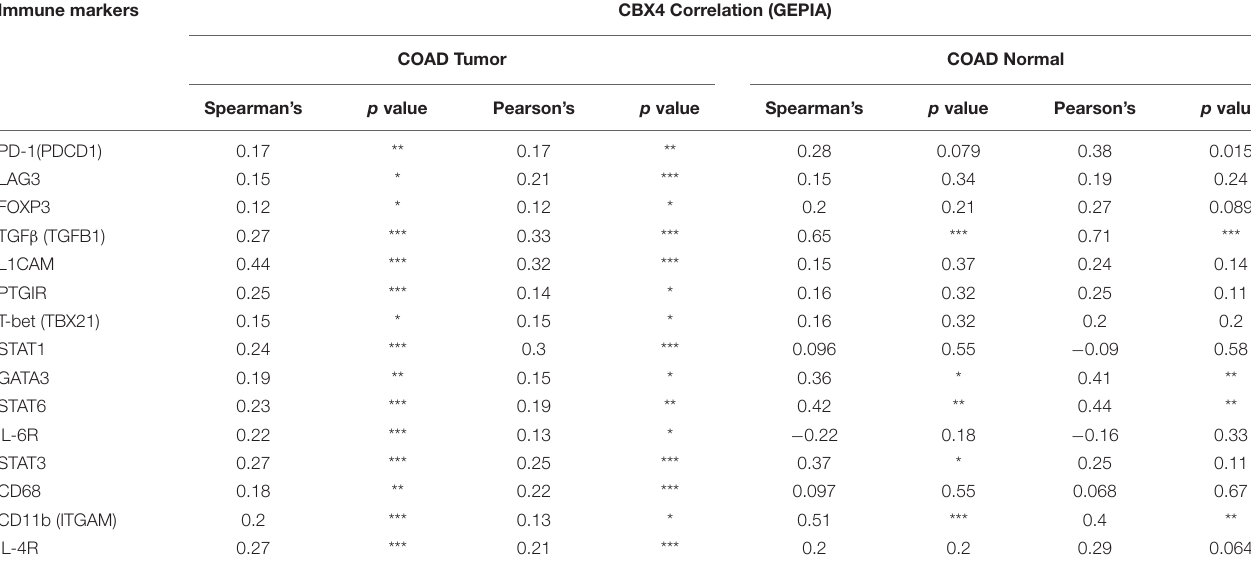
TABLE 2 | Correlations between CBX4 and gene representatives of various functional cell subsets in COAD determined by GEPIA. Immune markers CBX4 Correlation (GEPIA) COAD Tumor COAD